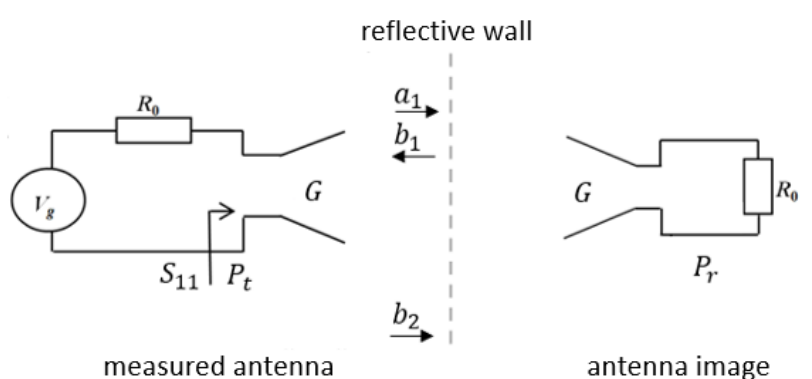
Figure 19. Measurement configuration for the single-antenna method.